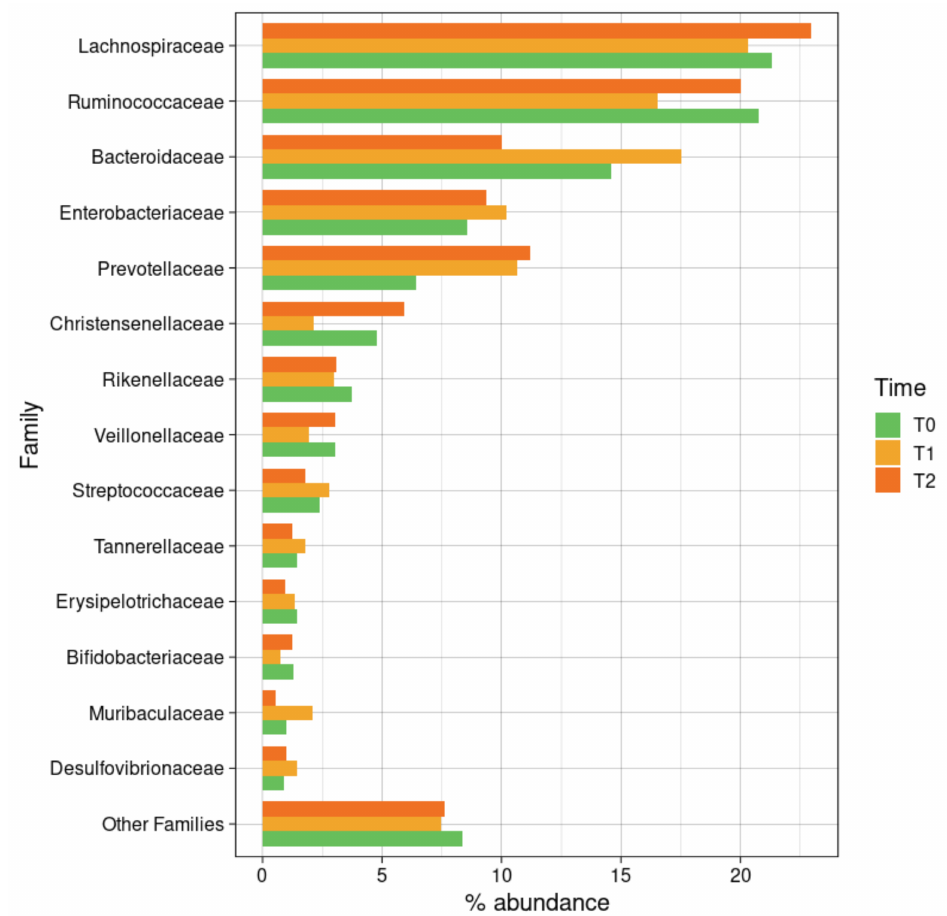
Figure 8. Taxonomic composition of the CKD gut microbiota at family level. Barplots of average microbial relative abundances at family level for CKD patients at baseline (CKD T0) and after 3 and 6 months of Meriva ® supplementation (respectively, CKD T1 and